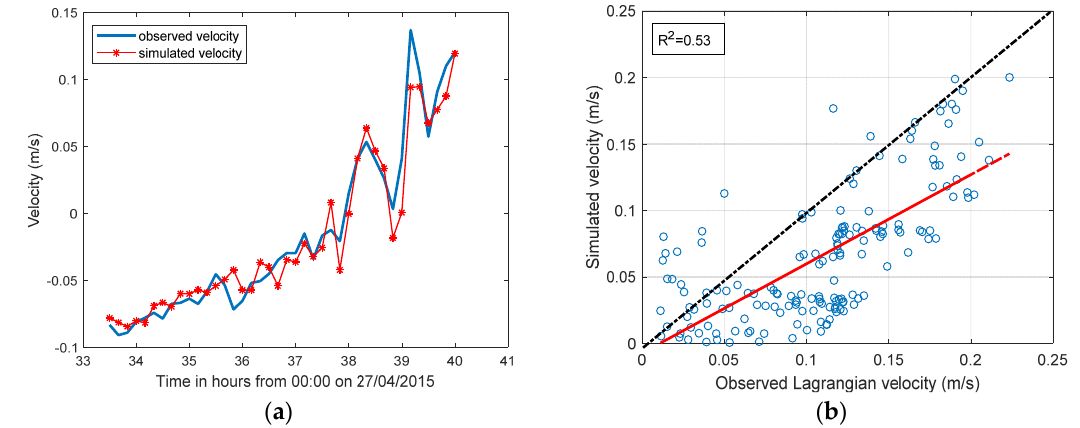
Figure 13. ( a ) Eulerian validation of the model by comparing the simulated and observed velocity using 30% of the data; ( b ) relationship between observed Lagrangian velocity and simulated velocity.